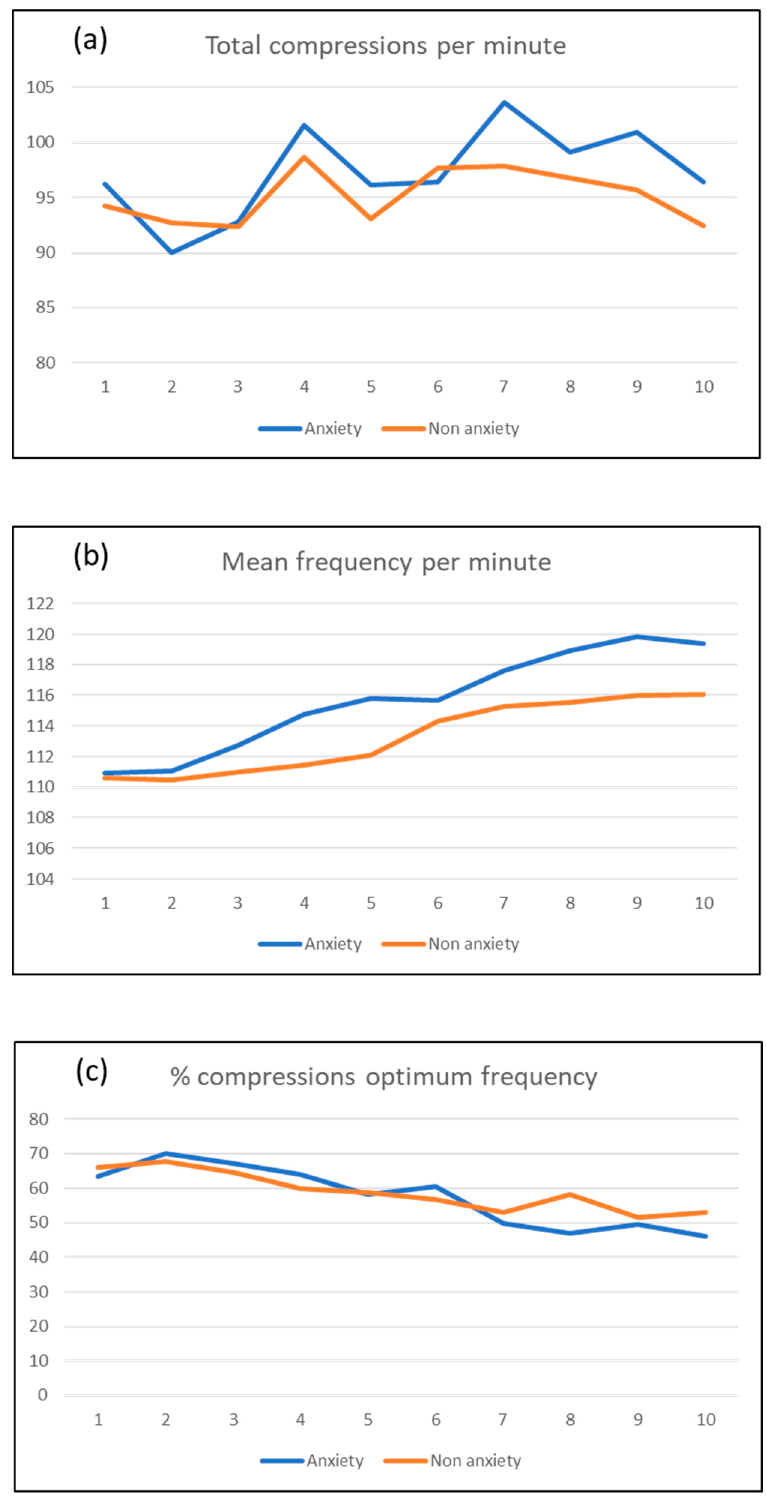
Figure 3. Quality of CPR according to anxiety: ( a ) total compressions per minute; ( b ) mean frequency per minute; and ( c ) present of compressions at optimum frequency.